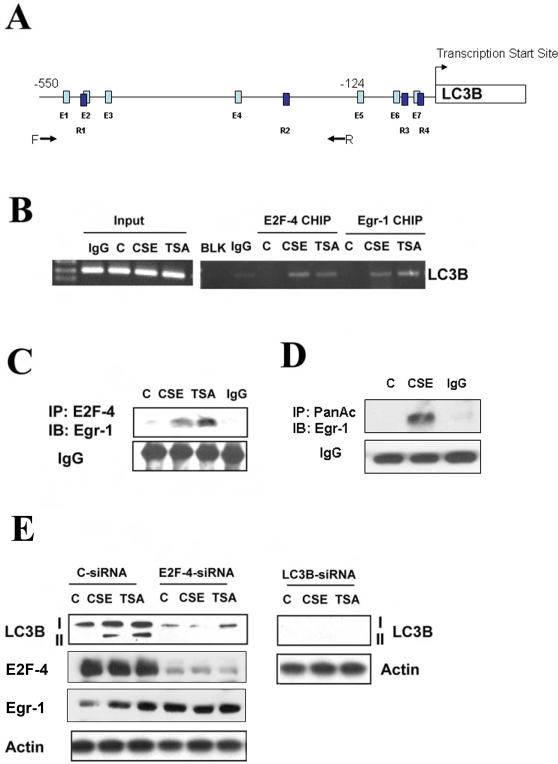
Regulation of LC3B by Egr-1 and E2F-4.(A) Putative Egr1 and E2F4 binding sites in the LC3b promoter. PCR primer locations for the CHIP analysis are labeled by arrows. Putative E2F4 (E1 to E7) and Egr1 (R1 to R4) binding sites are indicated as light and dark blue bars, respectively. The nucleotide locations for putative E2F1 and Egr1 sites are shown in Figure S1. (B) Increased DNA binding of E2F-4 and Egr-1 to the LC3B promoter by CSE and TSA. Beas-2B cells were treated with 20% CSE or 100 nM TSA for 1 h and subjected to CHIP assay as described in Methods. Chromatin samples were immunoprecipitated with anti-E2F-4 or anti-Egr-1 and evaluated for factor binding to the LC3B promoter region. (C) Beas-2B cells were treated with 20% CSE or 100 nM TSA for 1 h. Lysates were immnuoprecipitated (IP) with anti-E2F-4 and immunoblotted (IB) with anti-Egr-1. IgG served as the standard. CSE and TSA increased E2F-4 and Egr-1 complex formation. (D) Beas-2B cells were treated with 20% CSE for 24 h. Lysates were immunoprecipitated (IP) with anti-pan acetyl antibody and immunoblotted (IB) with anti-Egr-1. IgG served as the standard. CSE increased acetylation of Egr-1. (E) Effect of E2F-4 on the CSE- and TSA-induced LC3B expression. Beas-2B cells were pretreated with control siRNA (C-siRNA), E2F-4-siRNA, LC3B siRNA for 48 h, followed by the treatment with 20% CSE or 100 nM TSA for an additional 24 h. Cells were then harvested for Western blot analysis. β-Actin served as the standard.